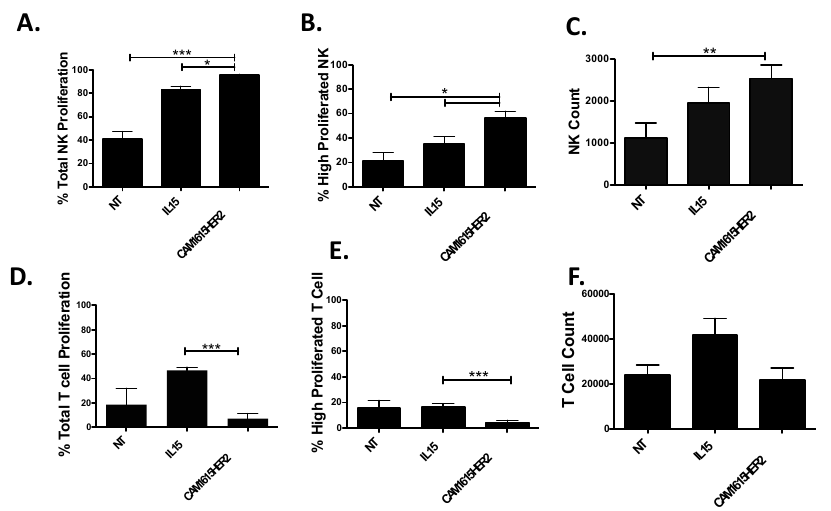
Figure 2. CAM1615HER2 TriKE induces specific NK cell expansion. PBMCs were CellTrace labeled and put in culture with nothing (NT), recombinant human IL-15 (IL15; 30 nM), or the CAM1615HER2 TriKE (30 nM) for 7 days ( n = 6). Cells were then harvested and stained for surface markers to differentiate proliferation on NK cells (CD3 - CD56 + ; A – C ) or T cells (CD3 + CD56 - ; D – E ). The first column of panels shows the total proportion of cells that proliferated ( A and D ), the second column shows the proportion of cells that proliferated beyond three divisions ( B , E ), and the final column shows the total number of cells present ( C , F ). Error bars display mean ± SEM, and statistical significance was shown as * p < 0.05, ** p < 0.01, and *** p < 0.001.